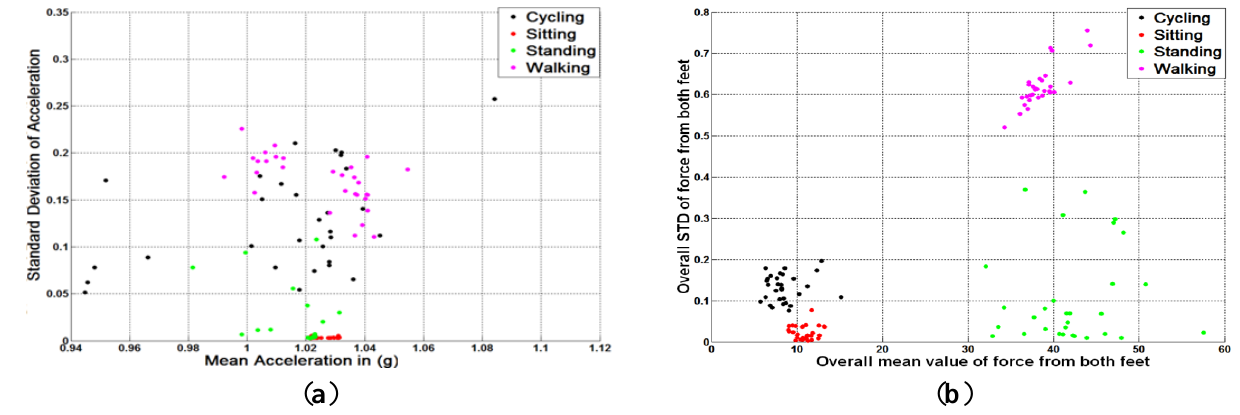
Figure 3. Clustering results of 120 samples from four human postures using ( a ) accelerometer versus using ( b ) foot force